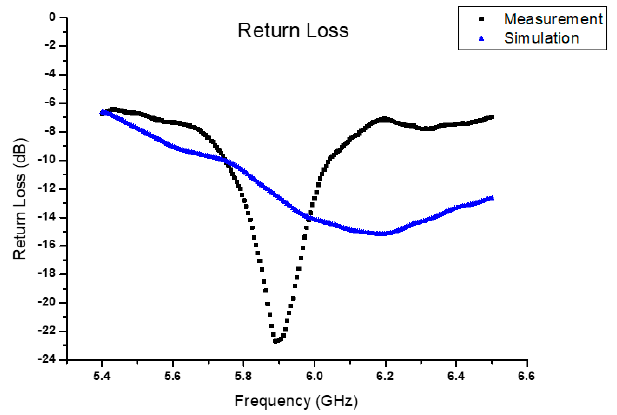
Figure 10. Simulated (blue color) and measured (black color) return loss of the monopole antenna